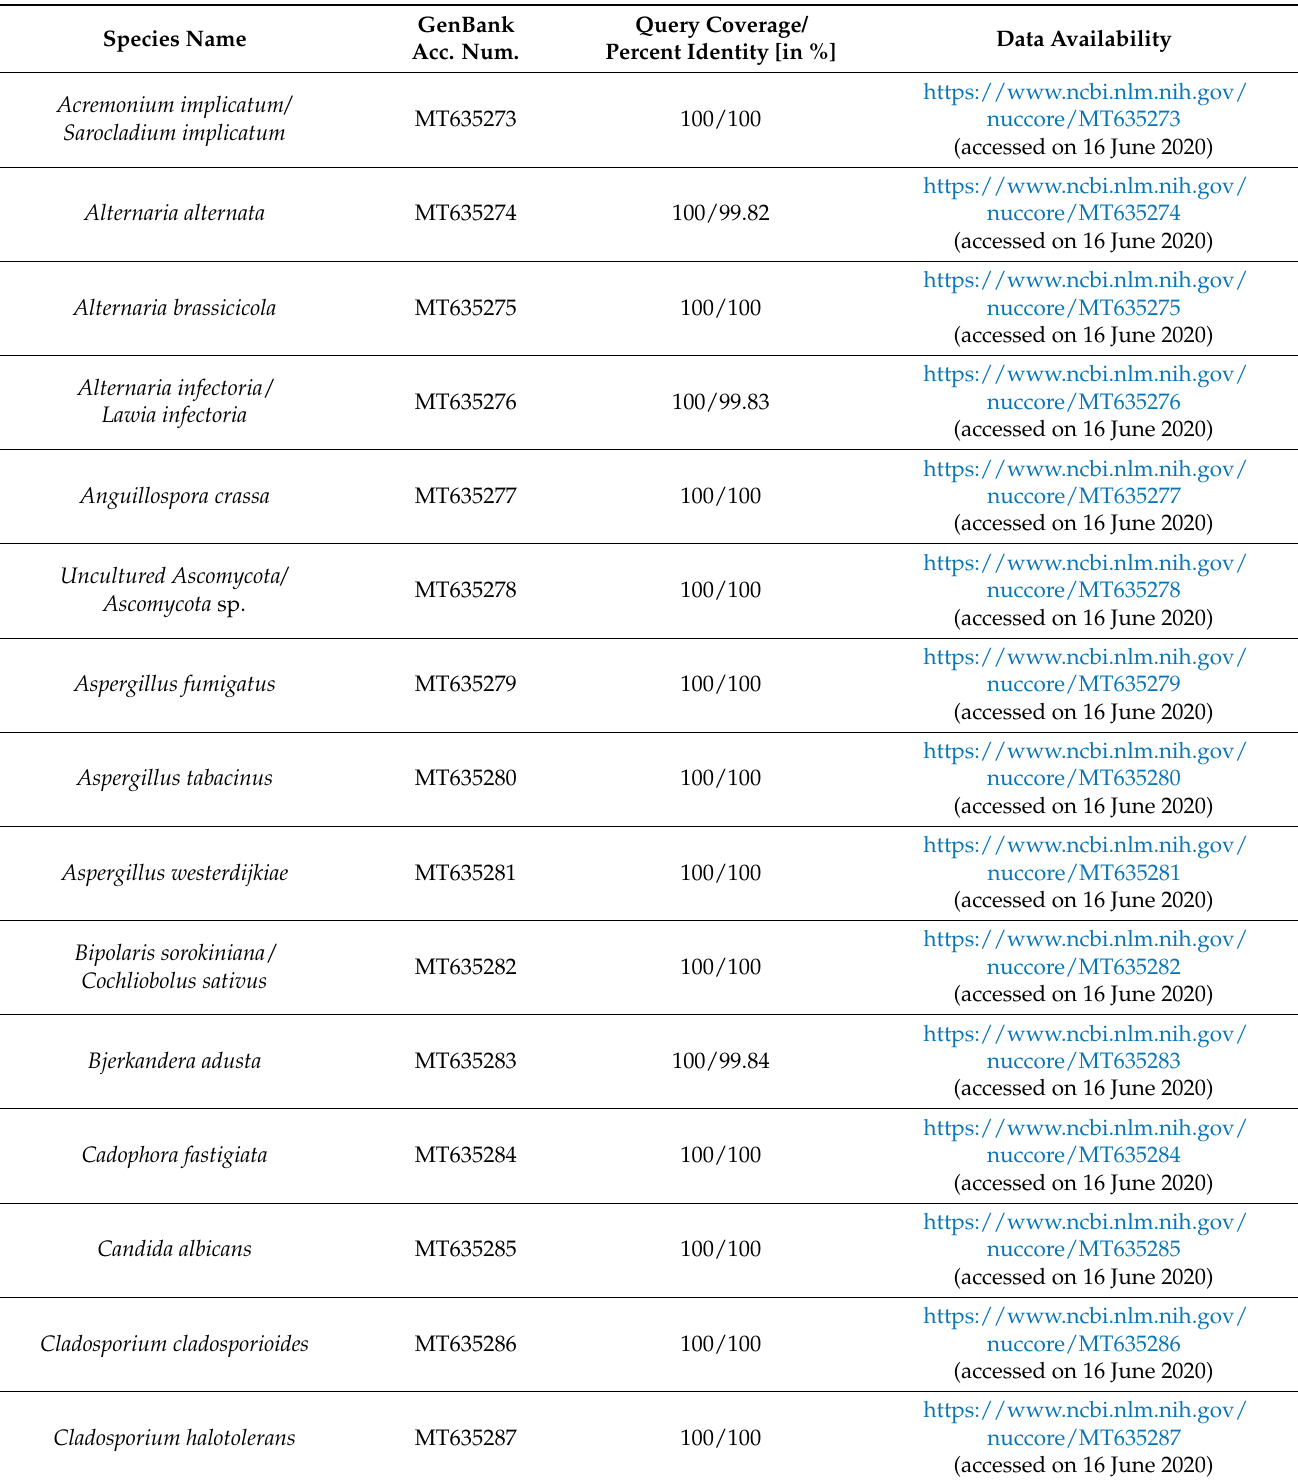
Table 2. List of fungal species and GenBank accession numbers of their sequences used in our molecular analysis. Query coverage [in %] demonstrates the percentage of the query sequence length that is included in the alignment. Percent identity is calculated as the % of characters within the covered part of the query that is